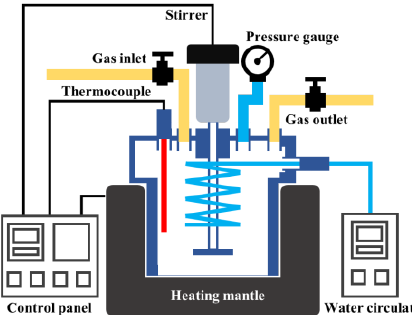
Figure 1. Hydrothermal carbonization reactor scheme.